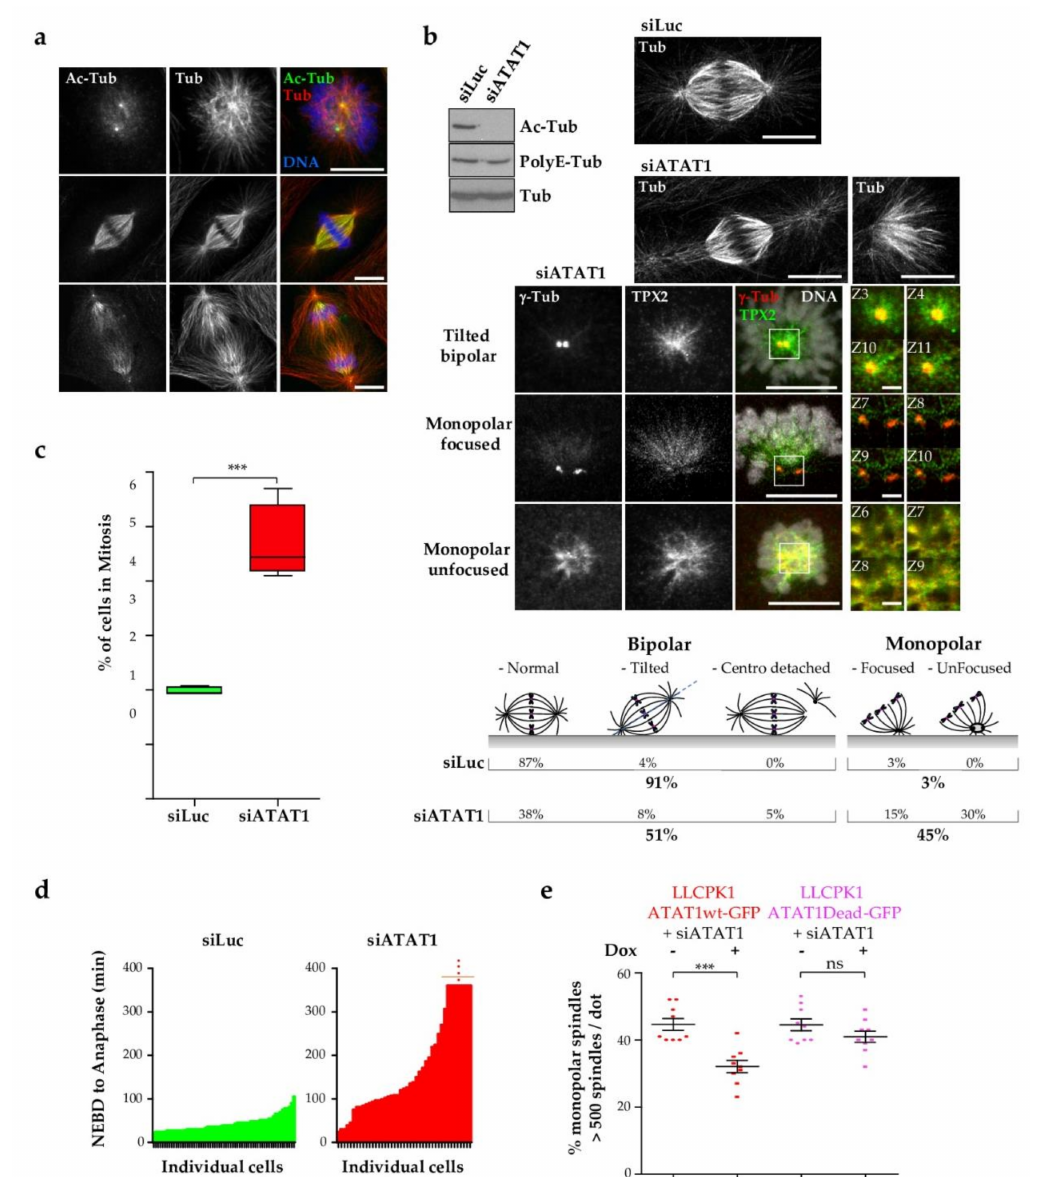
Figure 1. ATAT1 depletion induces mitotic defects. ( a ) Maximum intensity projection (MIP) images of mitotic LLCPK1 cells stained for acetyl-tubulin (Ac-Tub), tubulin (Tub) and DAPI. Different subsets of MTs are stained for Ac-Tub in prometaphase, metaphase, and anaphase. Scale bars are 10 µ m. ( b – d ) LLCPK1 cells transfected for 48 h with siRNAs directed against luciferase (Luc) and ATAT1 . ( b ) Cell lysates were analyzed by western blot using Ac-Tub and PolyE-tubulin antibodies. Total tubulin antibody was used as loading control. Representative MIP images of tubulin-stained mitotic Luc- and ATAT1 -depleted cells as well as ATAT1 -depleted cells stained for γ -tubulin and TPX2 are shown. Scale bars are 10 µ m. Insets are single planes focusing on the centrosome region. Z section, as indicated shows that centrosomes may be in same or different planes. Z step is 0.18 µ m. Scale bar is 2 µ m. Cartoon illustrates the quantification of spindle phenotypes that were manually analyzed in siLuc and si ATAT1 cells. 100 to 300 spindles were analyzed per condition and per experiment ( n = 3). ( c ) Mitotic index of siLuc and si ATAT1 cells. 1000 to 5000 cells were counted per condition and per experiment ( n = 4). ( d ) Quantification of the time spent by siLuc and si ATAT1 cells between nuclear envelop breakdown (NEBD) and initiation of anaphase onset. Live imaging of GFP-Tubulin-expressing LLCPK1 cells transfected with Luc or ATAT1 -siRNAs